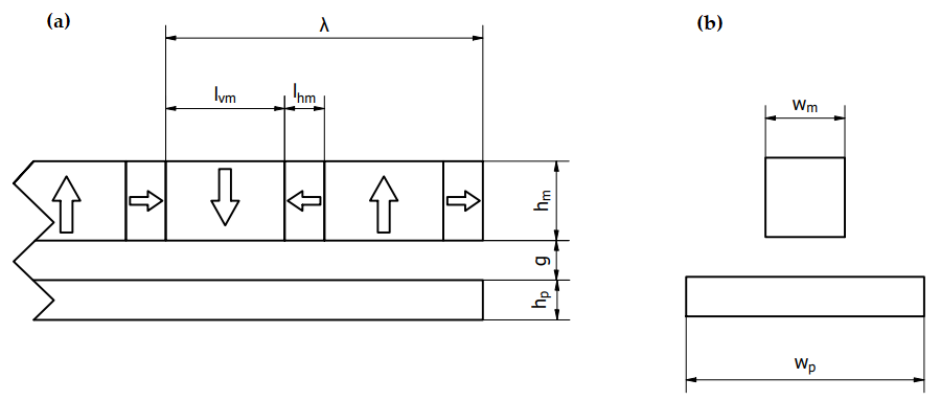
Figure 1. Halbach array with a wide vertically magnetized permanent magnet over a conductive track. Side view in picture ( a ) and front view in picture ( b ).